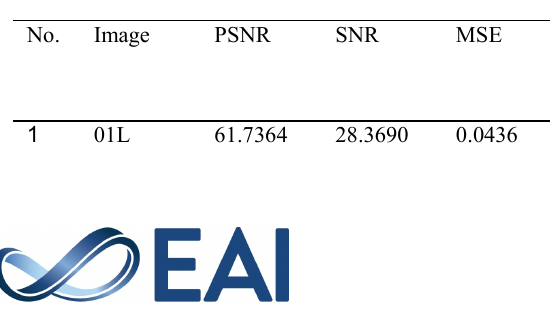
Table 1. Implementation of the algorithm for dataset color iris images with size 576x768